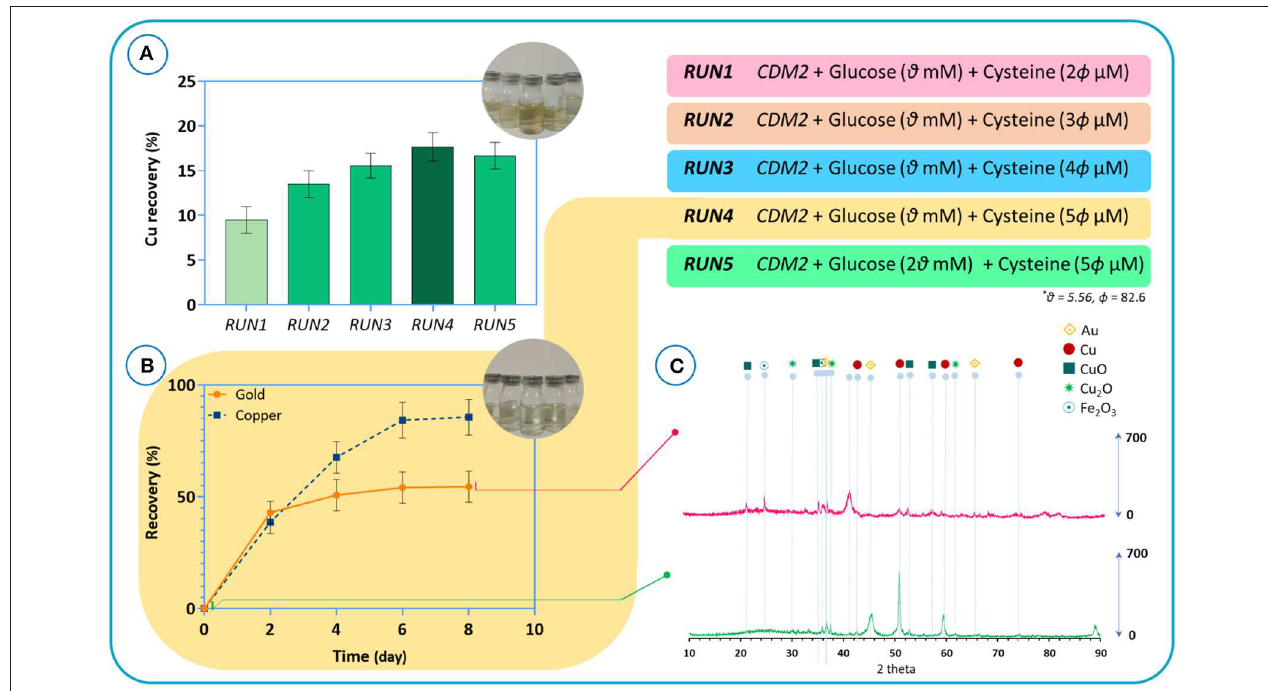
FIGURE 11 | (A) The results of copper recovery after 24h for different culture media, (B) the recovery results of gold and copper metals for the bioleaching of TPCB powders by using the RUN4 medium. Time = 0 refers to the beginning of the bioleaching process, (C) XRD patterns of the e-waste before bioleaching and of the residue after